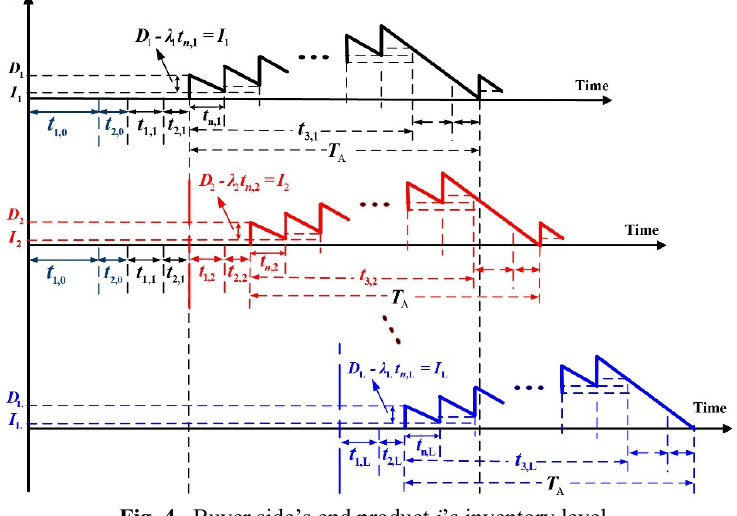
Fig. 4. Buyer side’s end product i ’s inventory